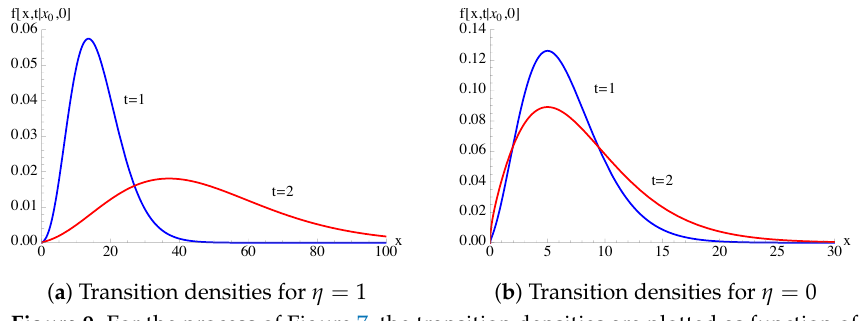
Figure 8. For the process of Figure 7, the conditional means and variances are plotted as function of t for various choices of ξ . The dotted functions indicate the related asymptotic means and variances.